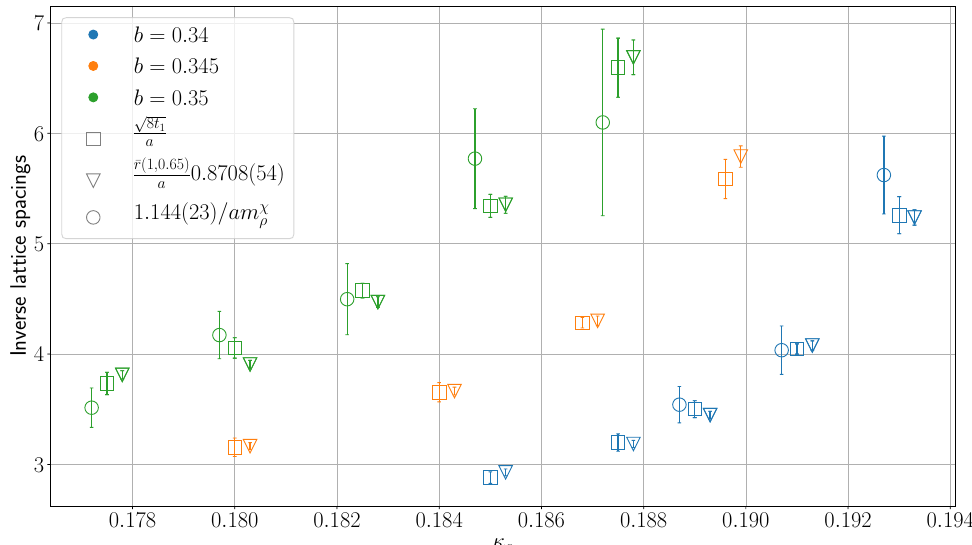
Figure 11. The inverse lattice spacing for the different values of ( b, κ and 1 /am χ have been rescaled with the conversion factor indicated in the legend to match the value ρ of √ 8 t 1 /a .